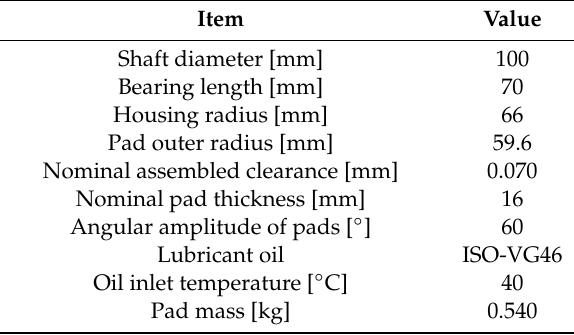
Table 6. Rocker-backed TPJB